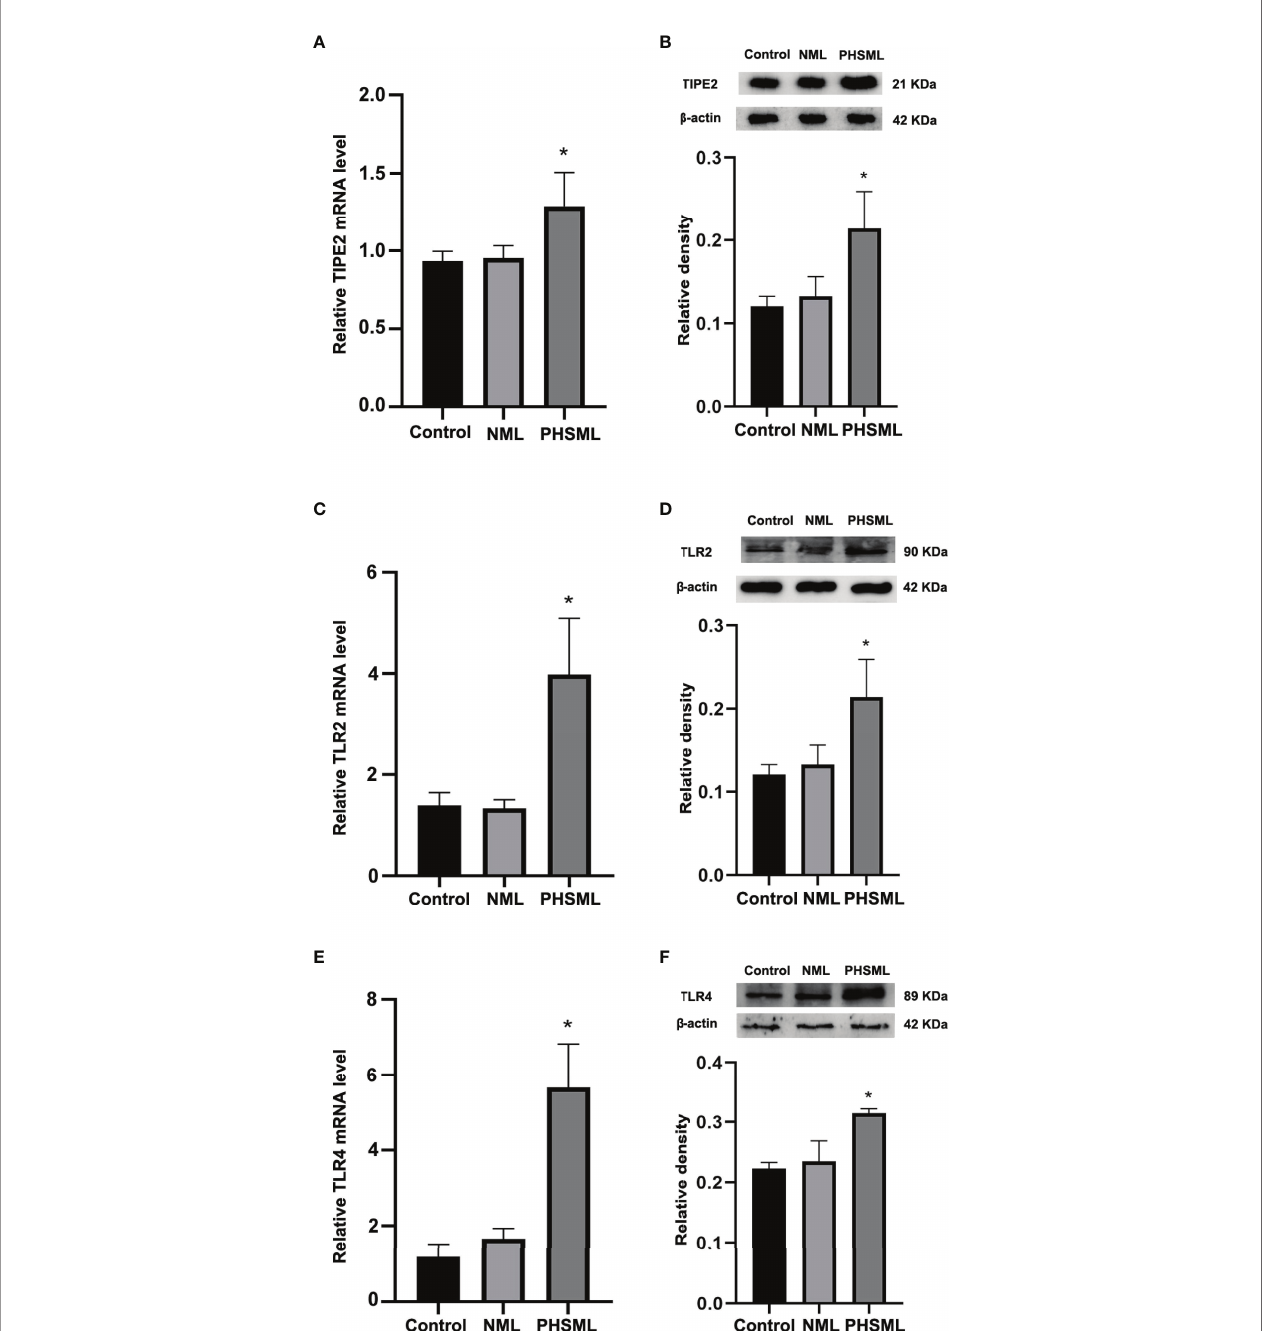
FIGURE 1 | PHSML increased the expression level of TIPE2, TLR2 or TLR4 in CD4 + T derived from WT mice. (A) The mRNA expressions of TIPE2 in CD4 + T lymphocytes following stimulation with PHSML. (B) The protein expressions of TIPE2 in CD4 + T lymphocytes following stimulation with PHSML. Compared to the Control group, PHSML increased the level of TIPE2. (C) The mRNA expressions of TLR2 in CD4 + T lymphocytes following stimulating of PHSML. (D) The protein expressions of TLR2 in CD4 + T lymphocytes following stimulating of PHSML. (E) The mRNA expressions of TLR4 in CD4 + T lymphocytes following stimulating of PHSML. (F) The protein expressions of TLR4 in CD4 + T lymphocytes following stimulating of PHSML. Compared to the NML group, PHSML increased the level of TLR2 and TLR4. Data are presented as mean ± SE (n = 3). *P < 0.05 vs control and NML